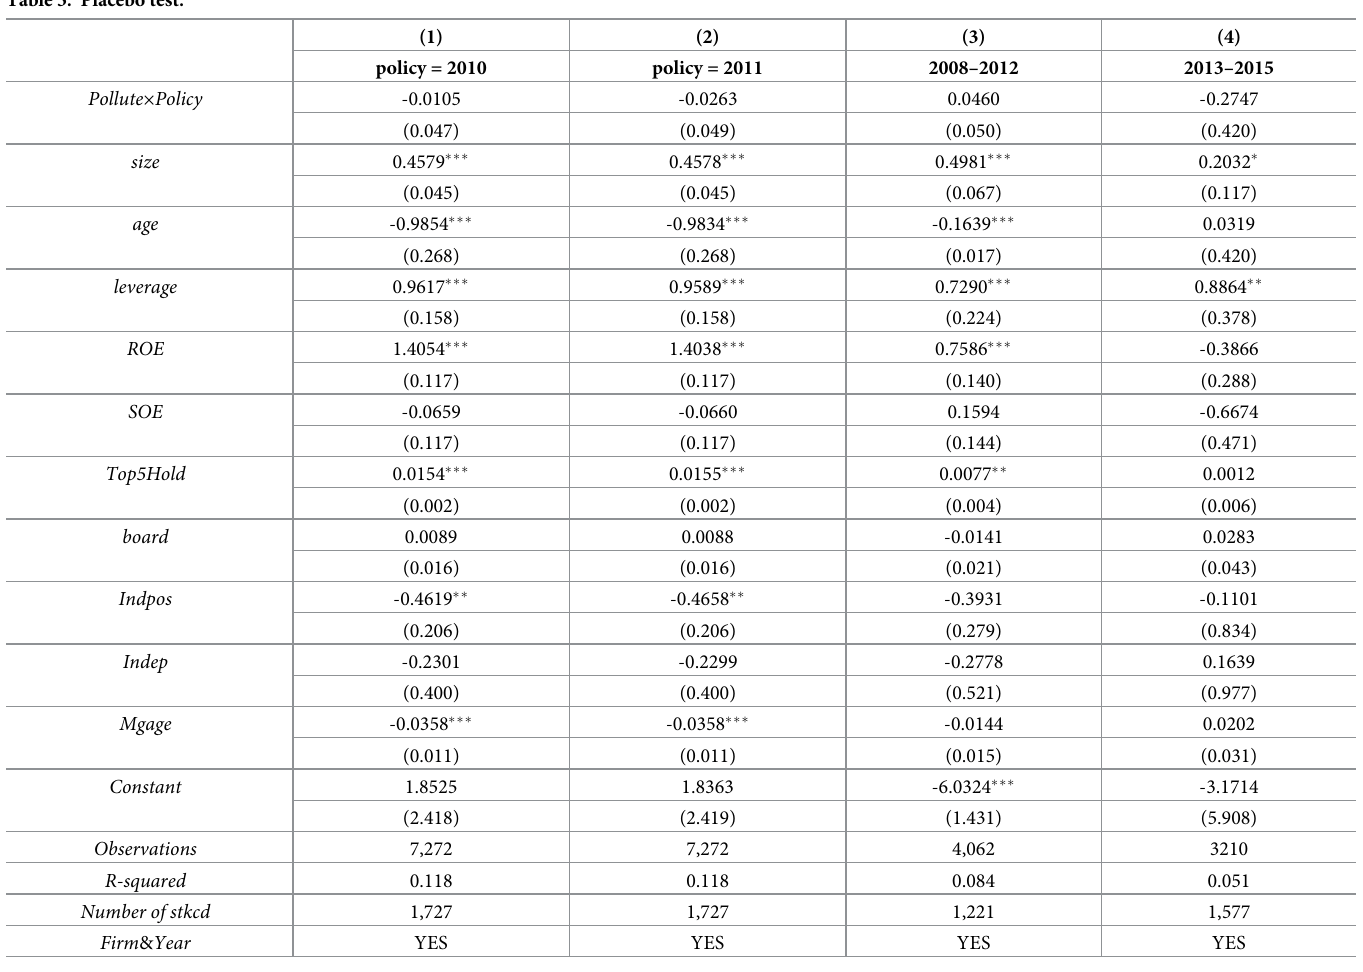
Table 5. Placebo